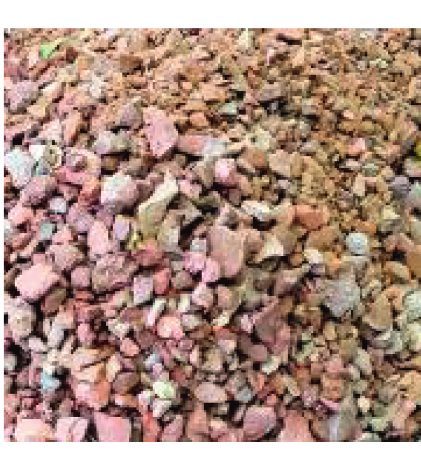
Figure 5: Coal gangue coarse aggregate. Table 2: Main chemical composition of coal